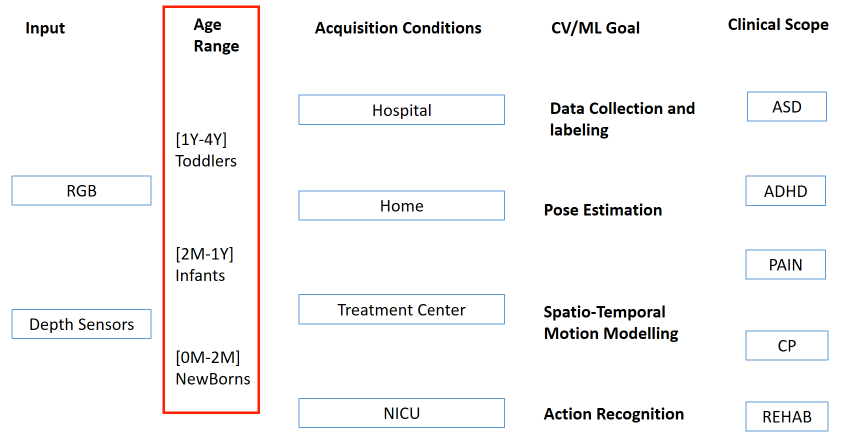
Figure 1. Introduced